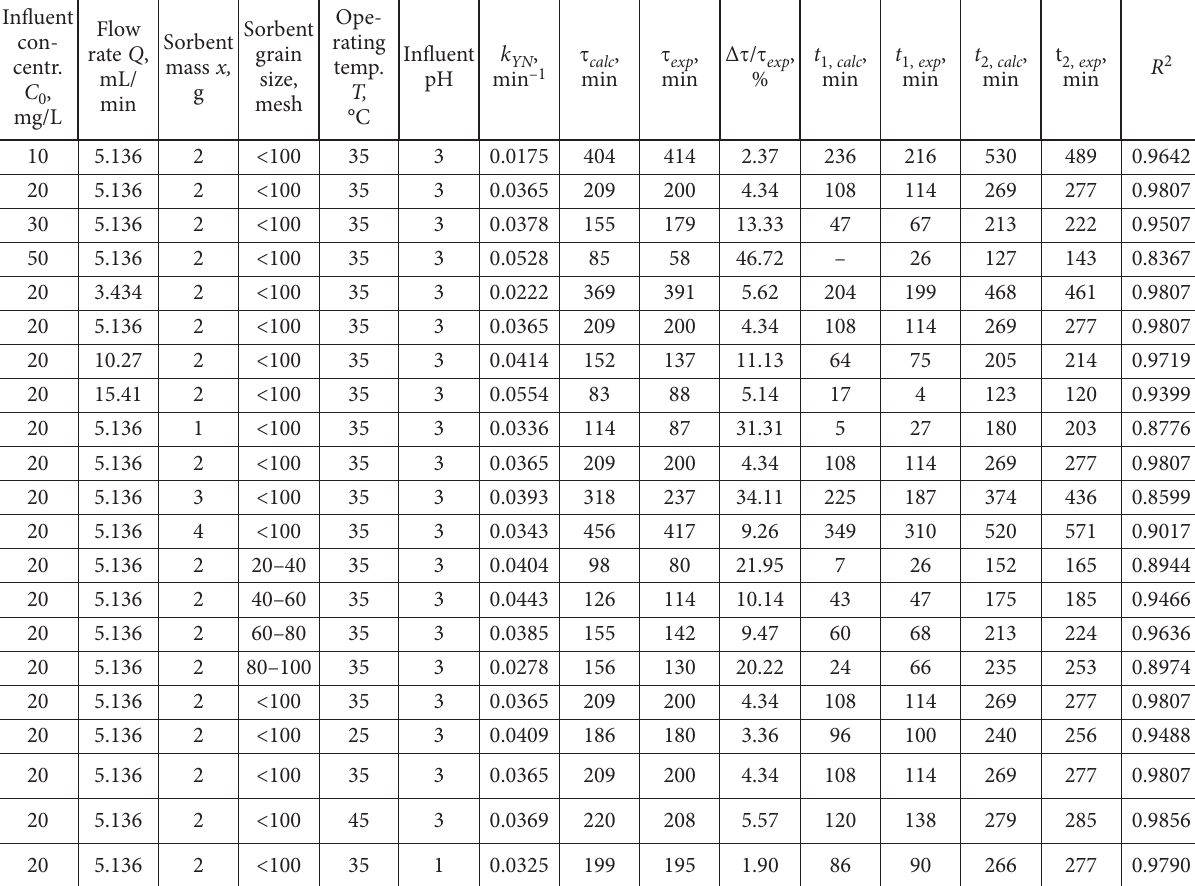
Table 2. Parameters of the Yoon–Nelson model using linear regression analysis for As(V) sorption to PC-Fe/C under different